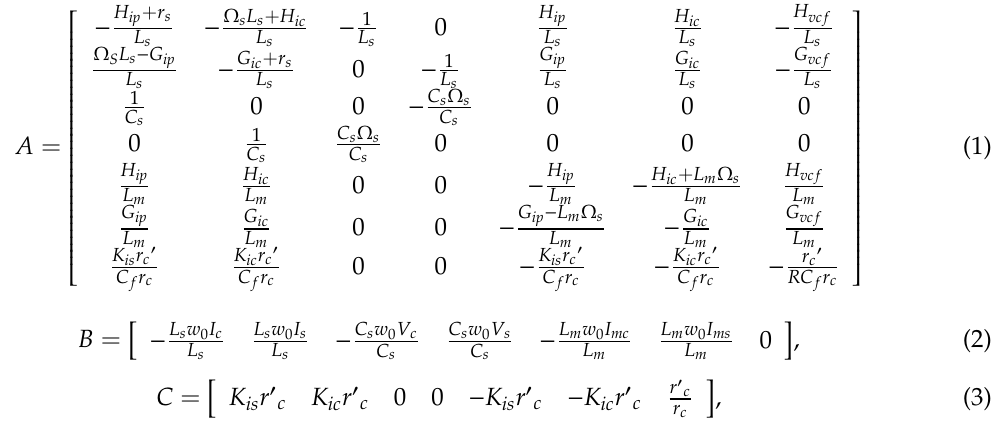
Figure 13. Theoretical output voltage waveform using the hybrid control algorithm shown in [43].